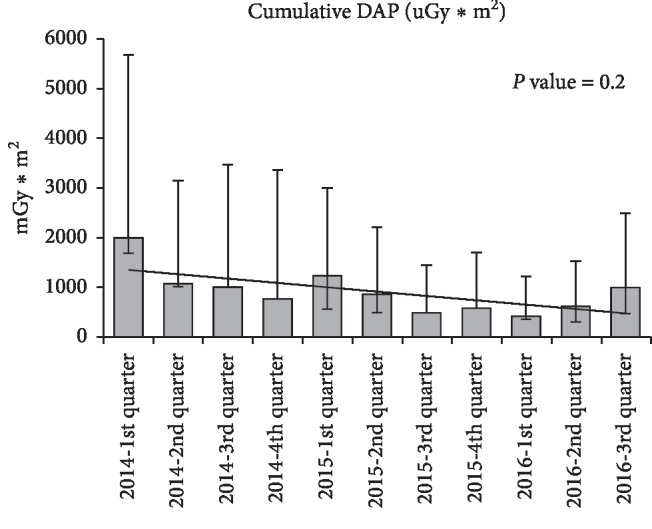
Quarterly cumulative dose area product (DAP) trend across centers (adjusted by center, age, and weight). P value = 0.2.